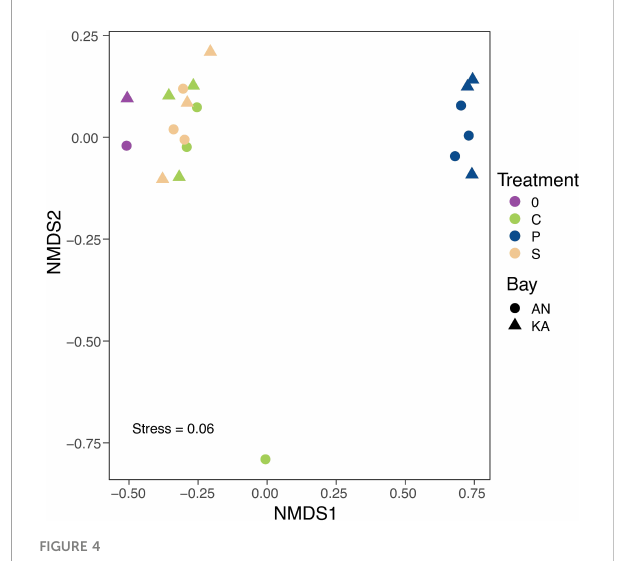
abundance. The colours in the graph represent different treatments, with purple representing day 0, green representing control, blue representing plankton extract treatment, and brown representing soil extract treatment, day 2. The shapes represent different bays, with triangles representing KA and circles representing AN. The stress value is 0.06 indicates that the NMDS plot provides a highly accurate representation in reduced dimensions.